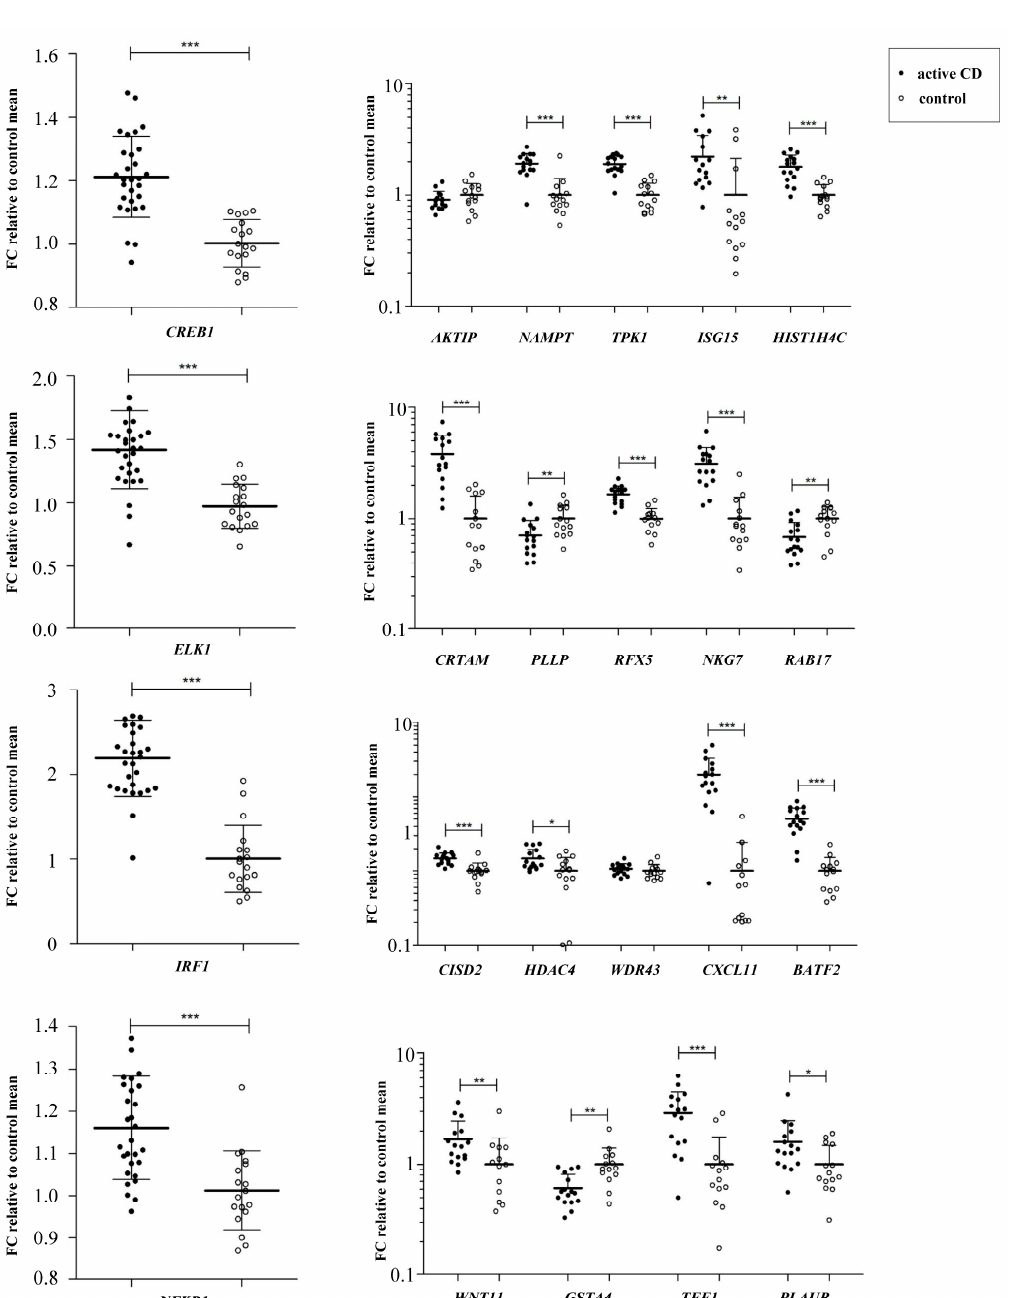
Figure 3. Gene expression analysis. Gene expression analysis of TFs identified by WGCNA (active CD n = 30, control n = 18) and their target genes (active CD n = 16, control n = 14) in duodenal biopsies. Data are expressed as mean ± SD (standard deviation) (*** p < 0.001, ** p < 0.01 and * p < 0.05).